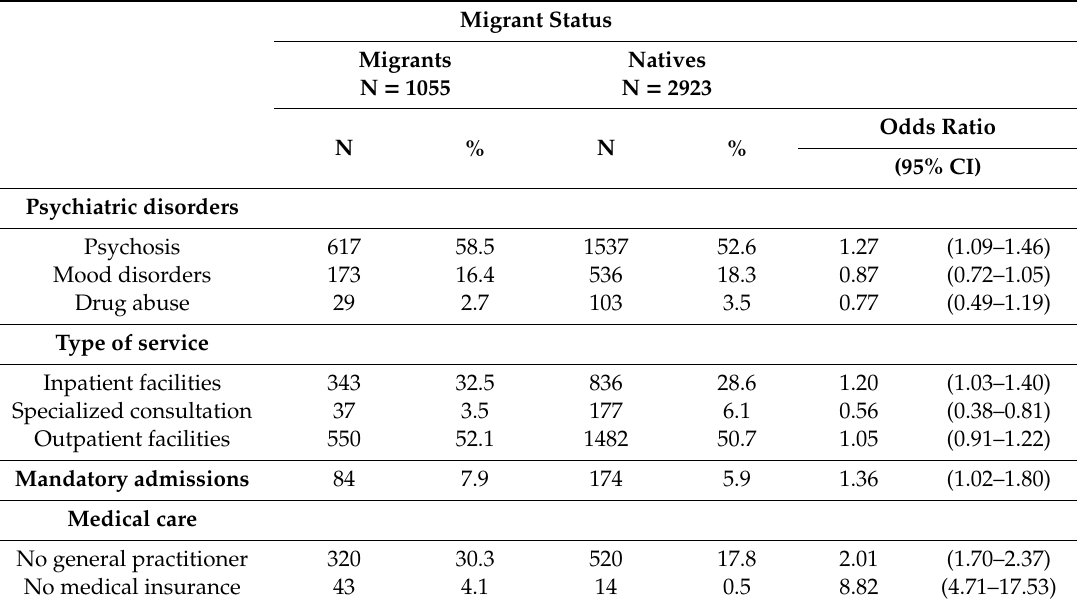
Table 2. Diagnosis and service use, by migrant